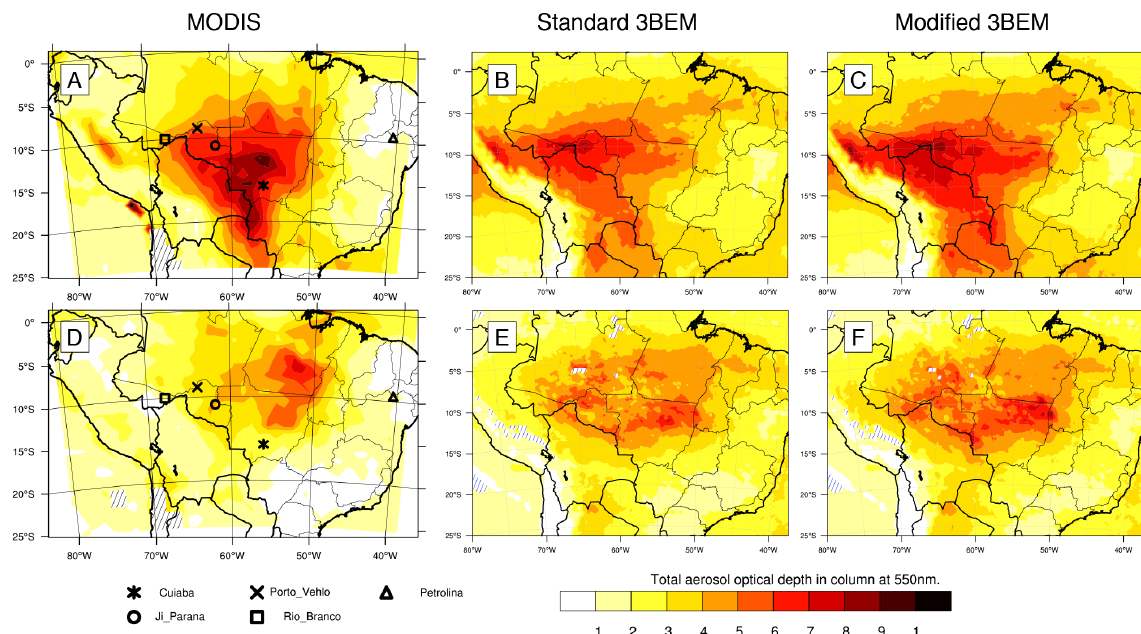
Figure 5. Horizontal maps of column AOD at 550nm, comparing the WRF-Chem model runs against MODIS measurements onboard the Aqua and Terra satellites. WRF-Chem data was extracted at times close to the overpass times of the Aqua and Terra satellites over South America: ( a , b and c ) for the first phase of the campaign (6–22 September 2012); ( d , e and f ) averaged over the second phase of the campaign (23–30 September). ( a and d ) combined Aqua and Terra satellite data; ( b and e ) from model runs using standard 3BEM emissions; ( c and f ) using modified 3BEM emissions. The symbols in panels (a) and (d) signify the location of AERONET sites operational during the campaign